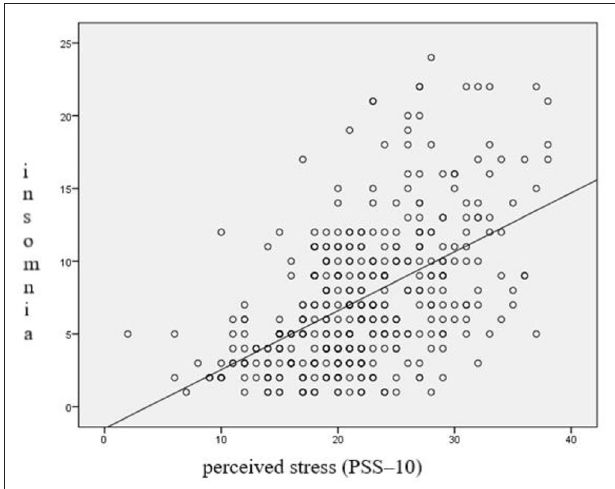
FIGURE 1 | Perceived stress level (PSS-10) and sleep disorders—insomnia (AIS).